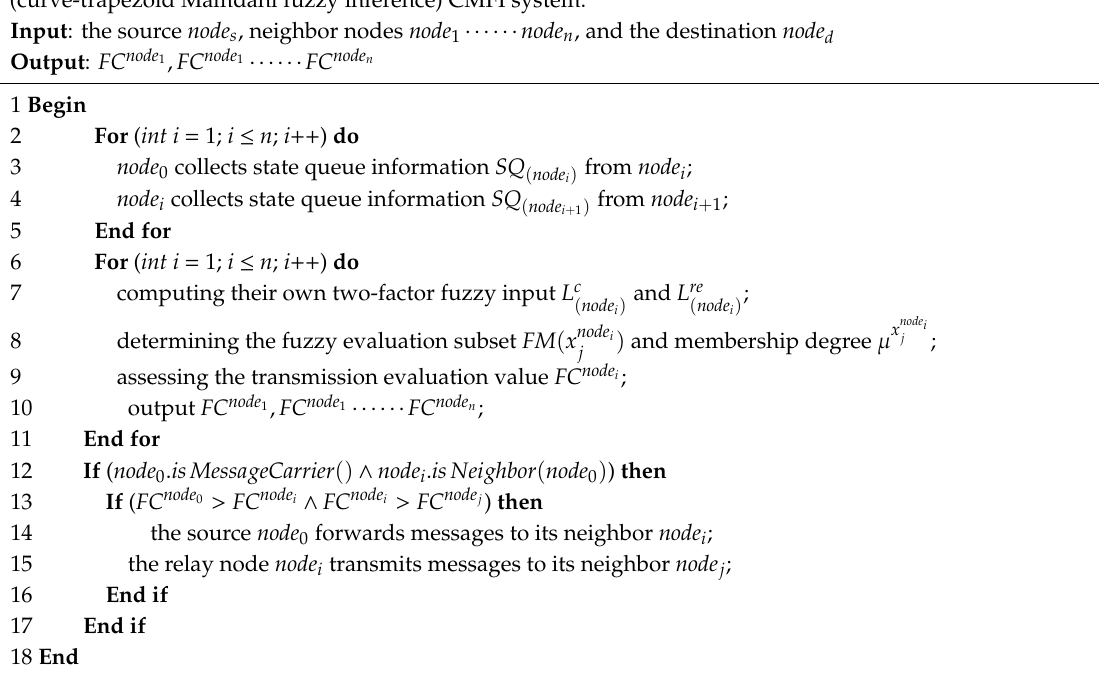
Algorithm 1. Data routing and forwarding in a delay-tolerant routing (DTCM) algorithm based on the (curve-trapezoid Mamdani fuzzy inference) CMFI